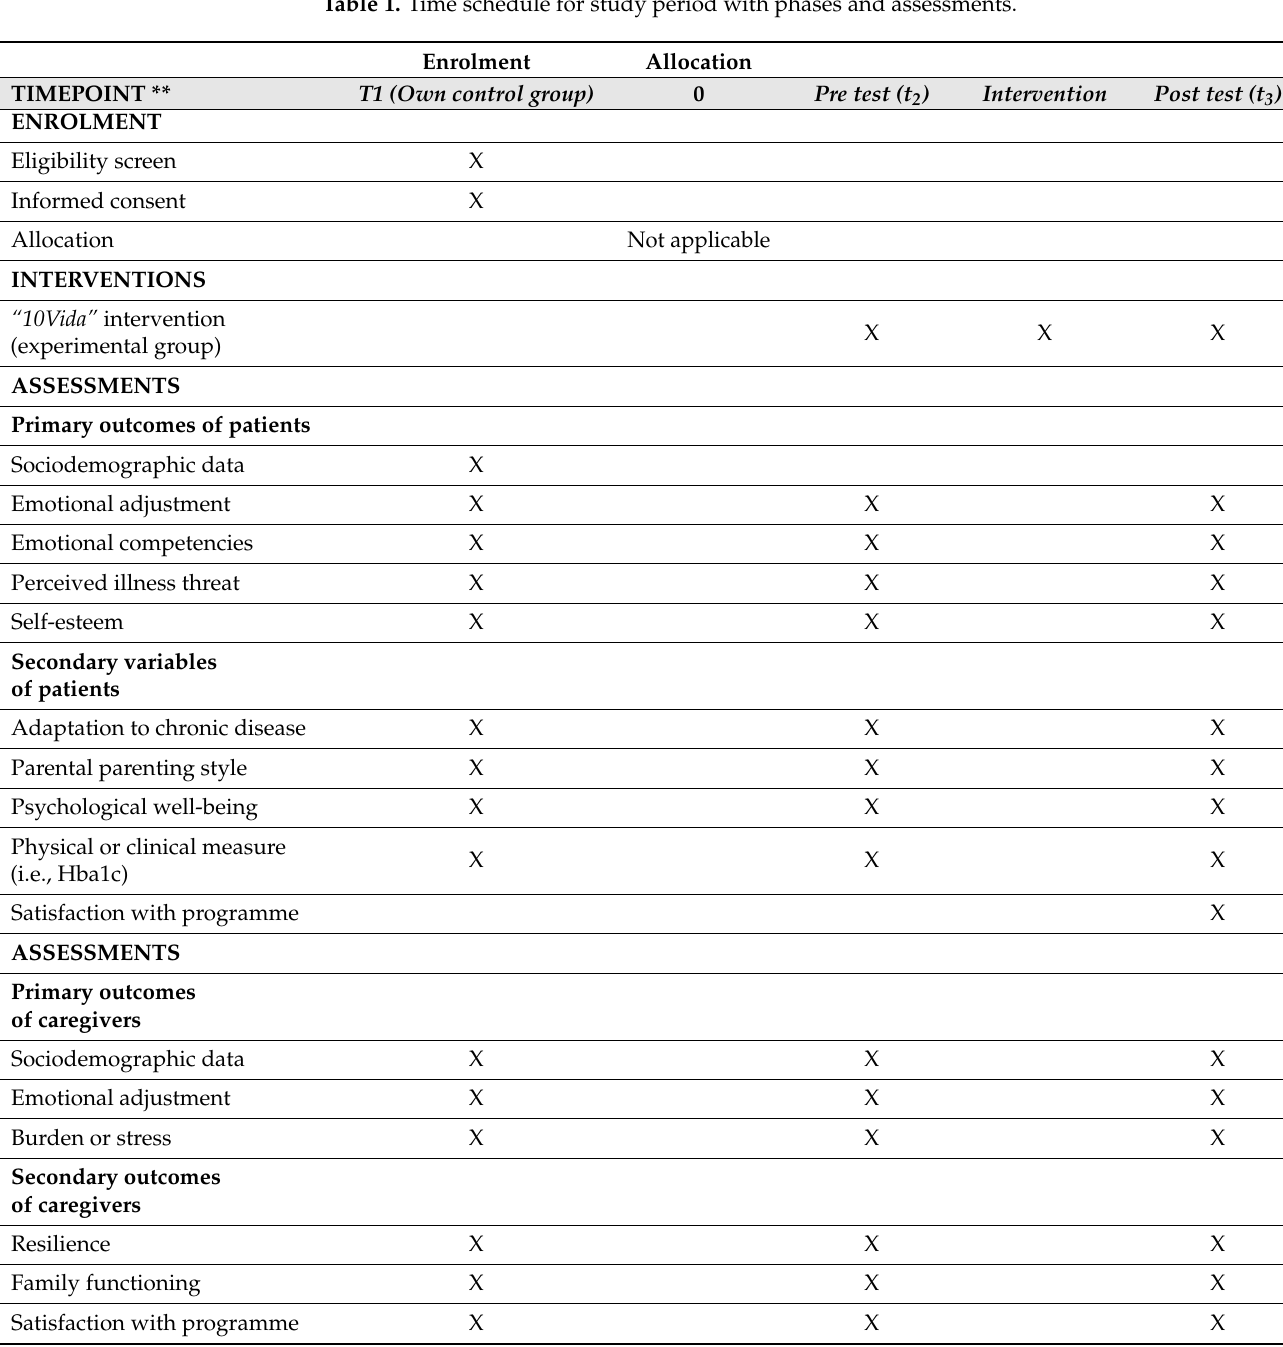
Table 1. Time schedule for study period with phases and